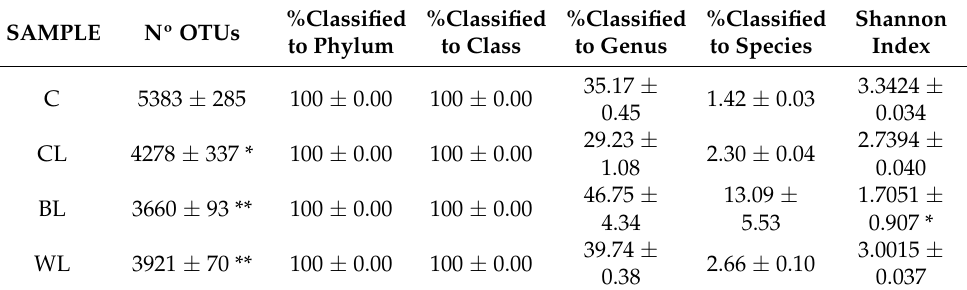
Table 2. Data obtained after bacterial community DNA sequencing and classification of Operational Taxonomic Units (OTUs) according to the CLC Microbial Genomics Module and the Greengenes database (n = 3, mean data ± s.e.m